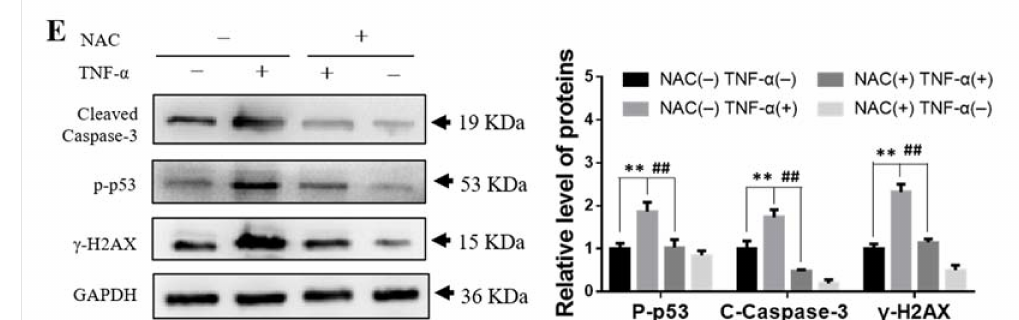
Figure 5. Scavenging ROS decreased DNA damage in BMSCs induced by TNF- α . ( A ) Relative ROS level in BMSCs treated with 0 or 1 ng/mL of TNF- α for 1 h. ** p < 0.01 compared with control group. ( B , C ) Western blot analysis of the expression of Cleaved caspase-3, p-p53 and γ -H2AX protein in BMSCs after the treatment with TNF- α . * p < 0.05 and ** p < 0.01 compared with control group. ( D ) Immunofluorescence staining of γ -H2AX in BMSCs in the presence and absence of NAC (10 µ M) for 0.5 h before exposure of TNF- α (1 ng/mL) for 6 h. Bar = 10 µ m. ( E ) Western blot analysis of the expression of p-p53, Cleaved caspase-3 and γ -H2AX protein in BMSCs treated with TNF- α and/or NAC. ** p < 0.01 compared with NAC ( − ) TNF- α ( − ) group; ## p < 0.01 compared with NAC (+) TNF- α (+) group. Each experiment was repeated at least three times.